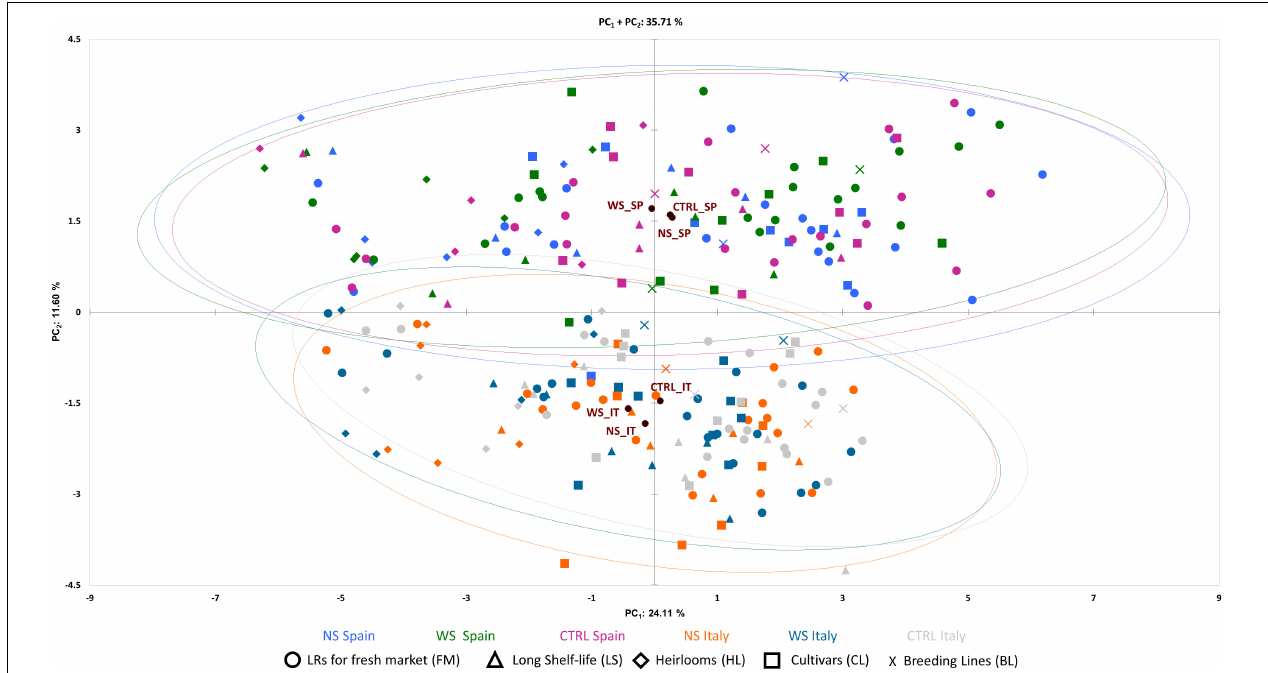
FIGURE 5 | Principal component analysis. Loading plot of the first (PC 1 ) and second (PC 2 ) principal components showing the variation for 30 traits scored in two environments. Accessions of different cultivar groups are represented by different colored symbols according to the applied treatment and cultivation site. Color and symbols are listed below the graph. Ellipses grouped the accessions for each treatment with a 95% CI.